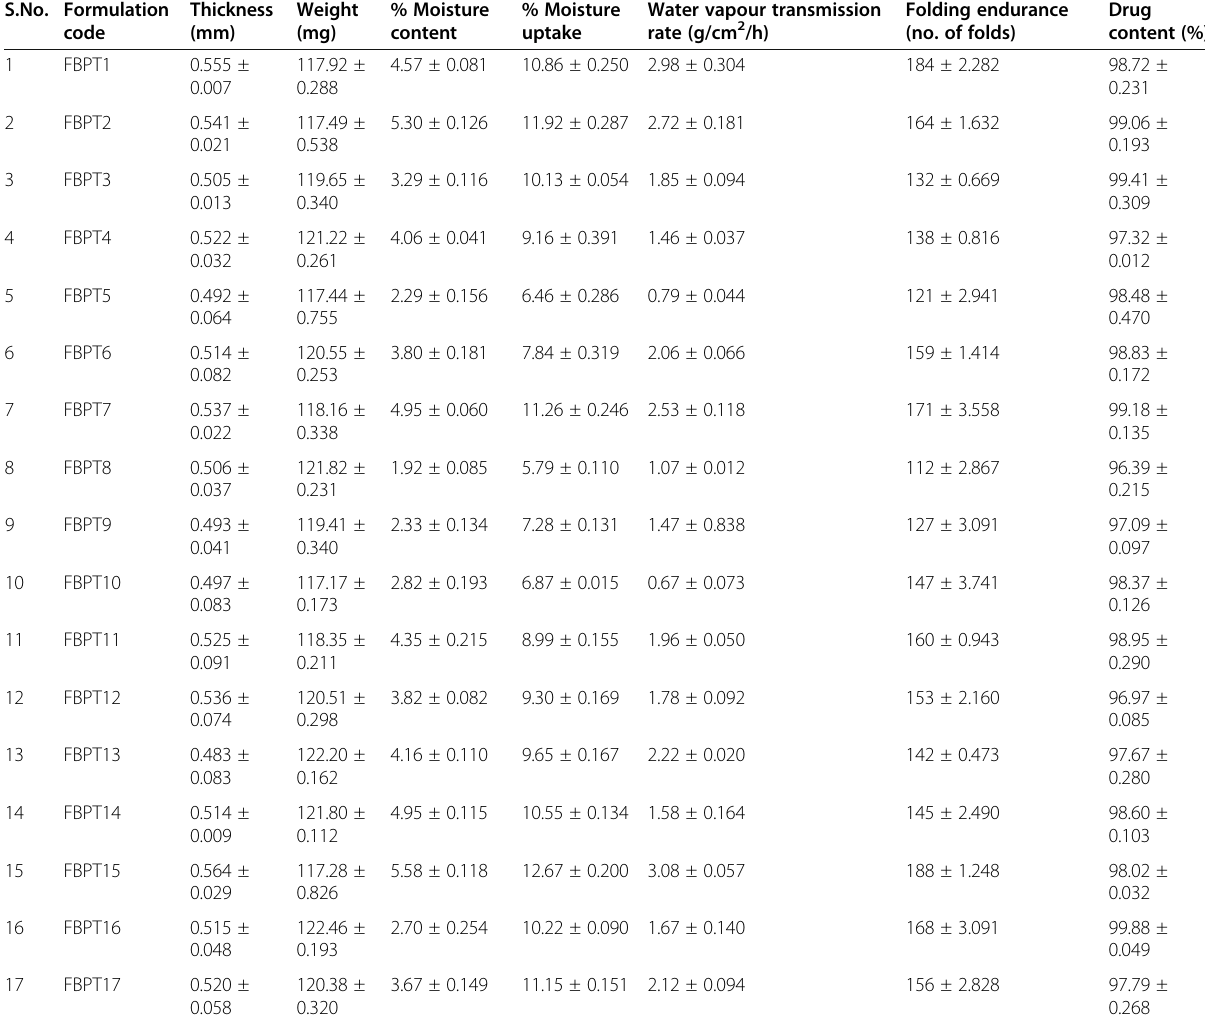
Table 3 Physicochemical characterization of flurbiprofen transdermal film S.No. Formulation